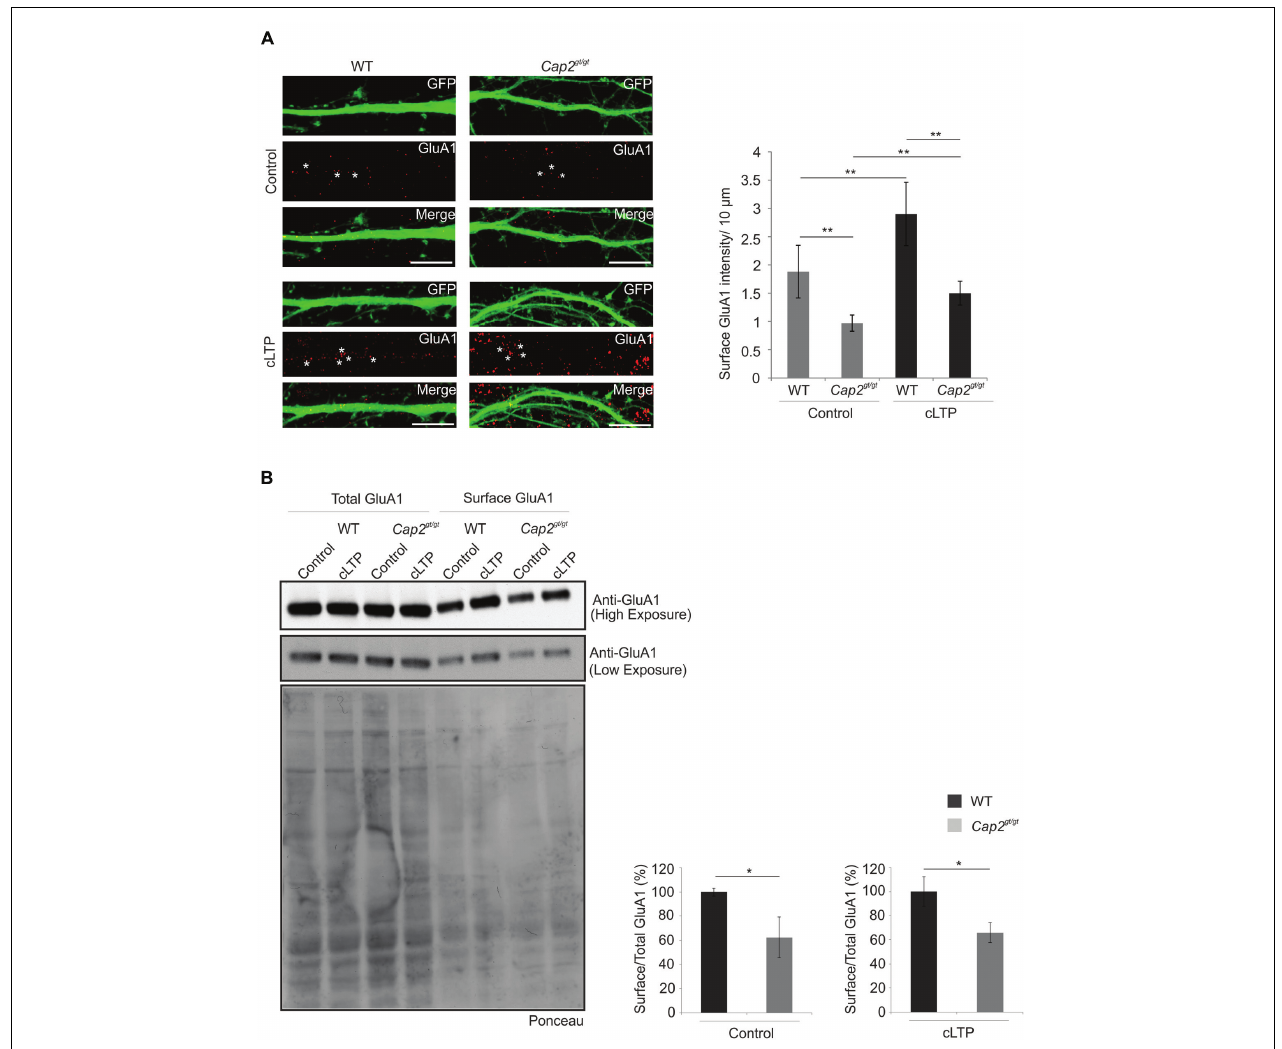
FIGURE 7 | Surface AMPA receptor trafficking is impaired in CAP2 null neurons. (A) pEGFP-C2 transfected WT and CAP2 mutant neurons labeled with antibodies against GluA1 in control and upon cLTP induction. Scale bar, 10 µ m. Quantification of data revealed a significant decrease in GluA1 surface intensity in control condition and upon cLTP induction. (WT control: 1.8 ± 0.46 surface GluA1 intensity (AU)/10 µ m; Cap2 gt / gt control: 0.97 ± 0.14 surface GluA1 intensity (AU)/10 µ m; white asterisk; n = 40 neurons from 3 set of different experiments; p < 0.01; WT cLTP: 2.9 ± 0.55 surface GluA1 intensity (AU)/10 µ m; Cap2 gt / gt cLTP: 1.5 ± 0.2 surface GluA1 intensity (AU)/10 µ m; white arrows; n = 40 neurons from 3 set of different experiments; p < 0.01). (B) Surface biotinylation and western blotting with GluA1 in control and cLTP induced cortical neurons. Quantification of data revealed a significant decrease in surface GluA1 in CAP2